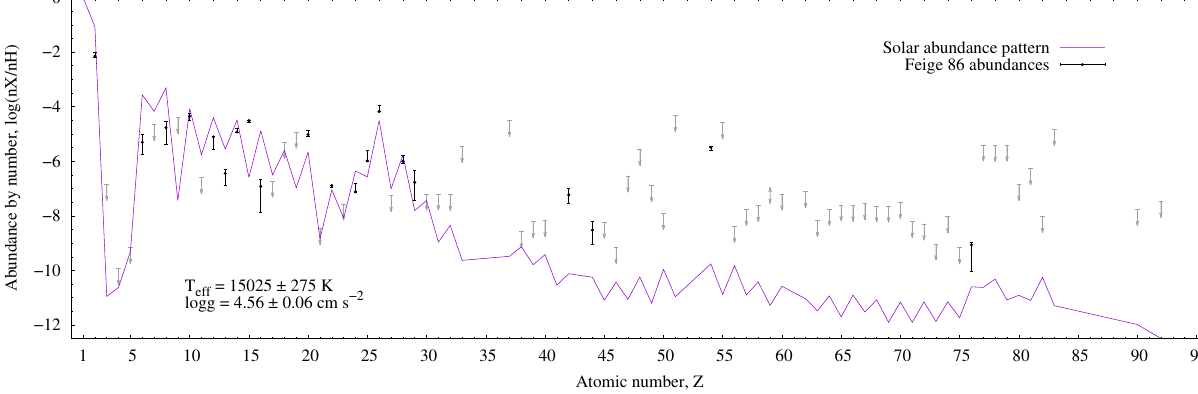
nosity fractions are log L / L −2.97, corresponding to a luminosity fraction ratio of